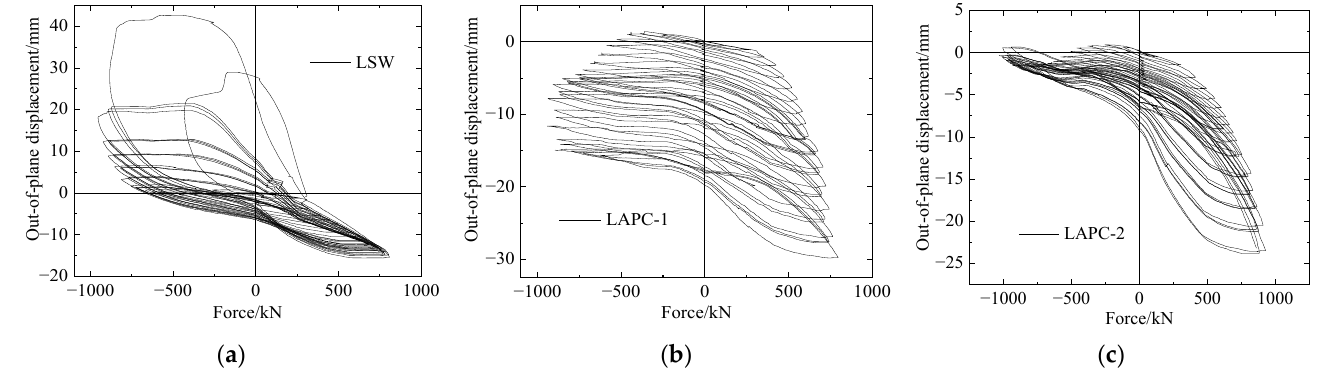
Figure 17. Force-out-of-plane displacement curves of specimens: ( a ) LSW; ( b ) LAPC-1; and ( c ) LAPC-2.